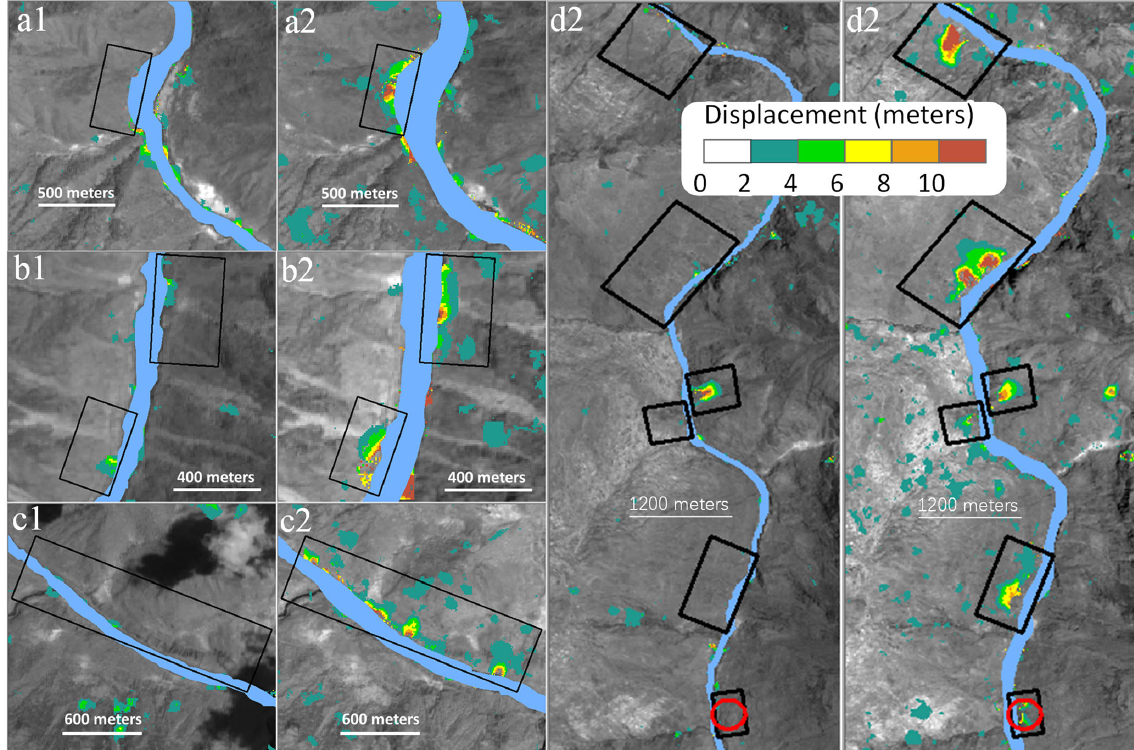
Figure 3. Moving slopes in four selected sections along the Jinsha River (a–d) before (November 2015–November 2018) and after (Novem- ber 2018–November 2019) the Baige floods. The left panels (a1, b1, c1, d1) are pre-flood results, and the right panels (a2, b2, c2, d2) are post-flood results. MD is short for Mindu village. The background images are cloud-free grayscale Sentinel-2 images before and after the 2018 floods. The red circles indicate concurrent landslides, and the black squares are slope